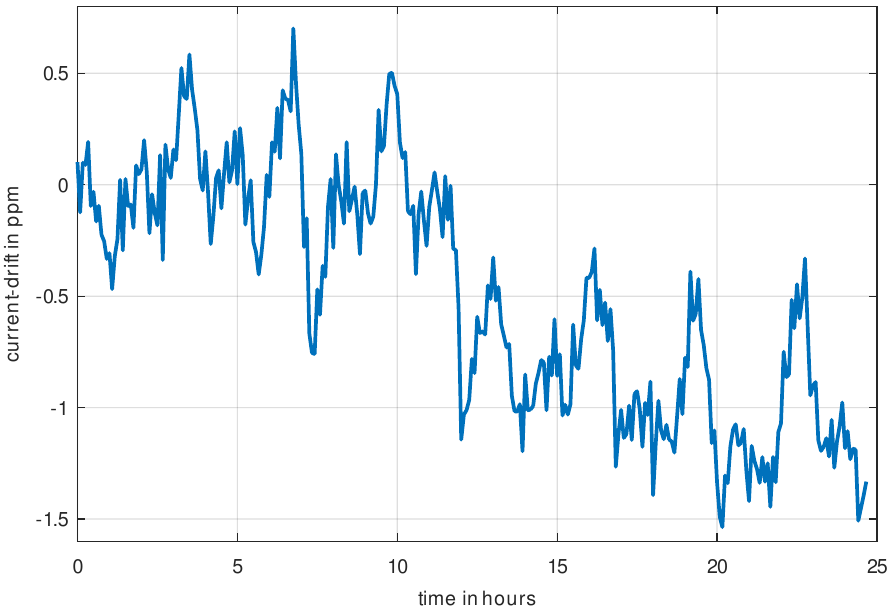
Figure 4. Current Drift over 24 h. The current samples were averaged over one minute. The current drift is approximately 1.5 ppm in 24 h.